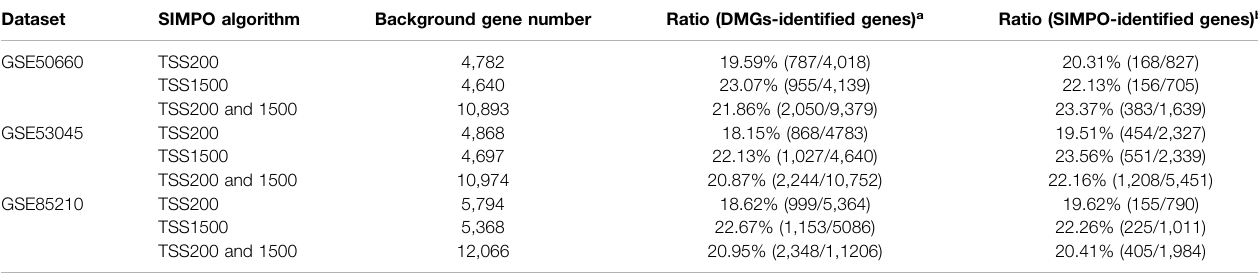
TABLE 2 | Ratios of known tobacco use disorder-related genes.